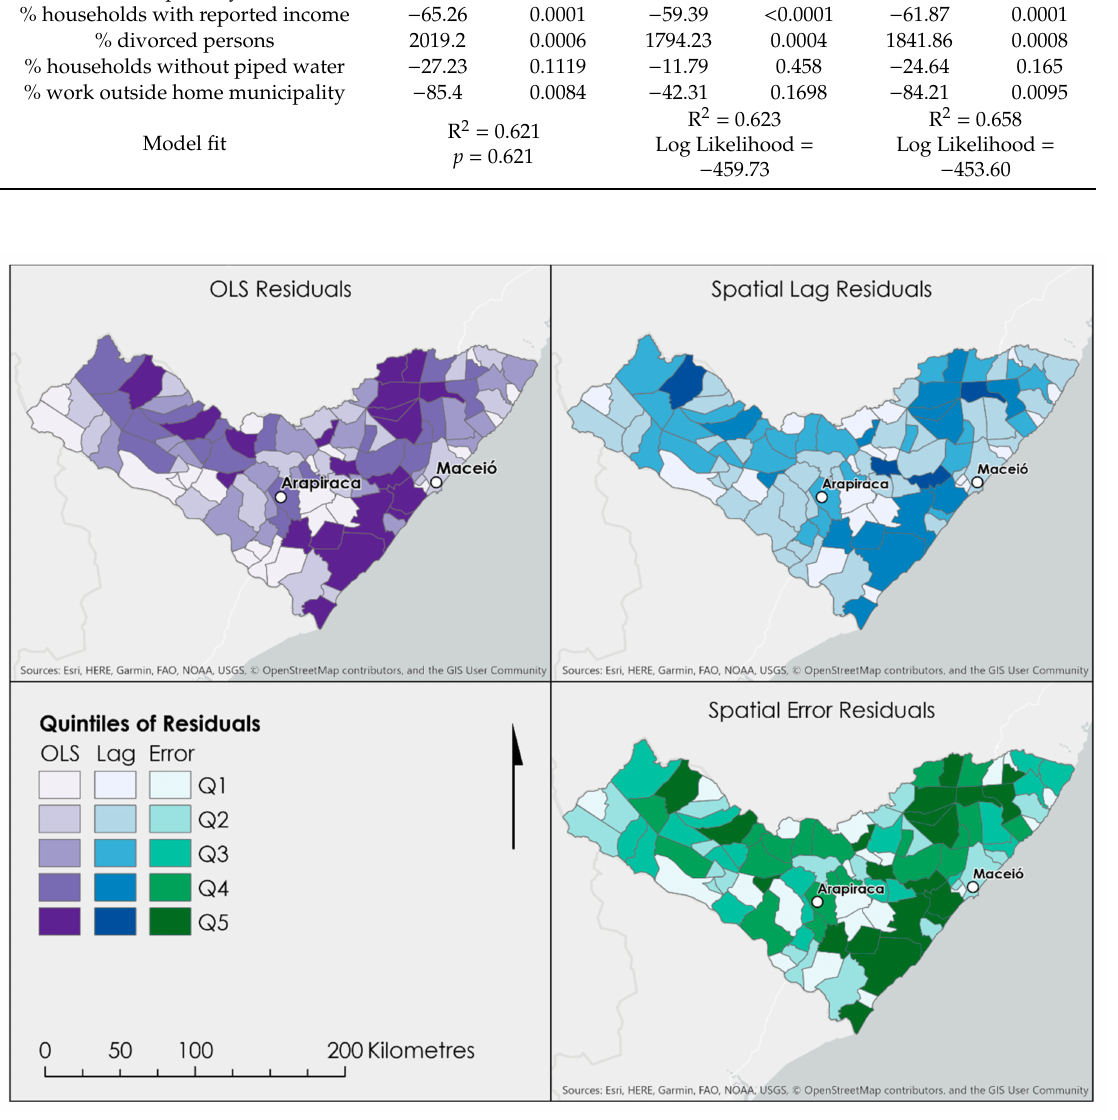
Figure 2. Regression model residuals indicating regions where the socioeconomic models overpredicted (higher quintiles) and underpredicted (lower quintiles) homicide rates in the study